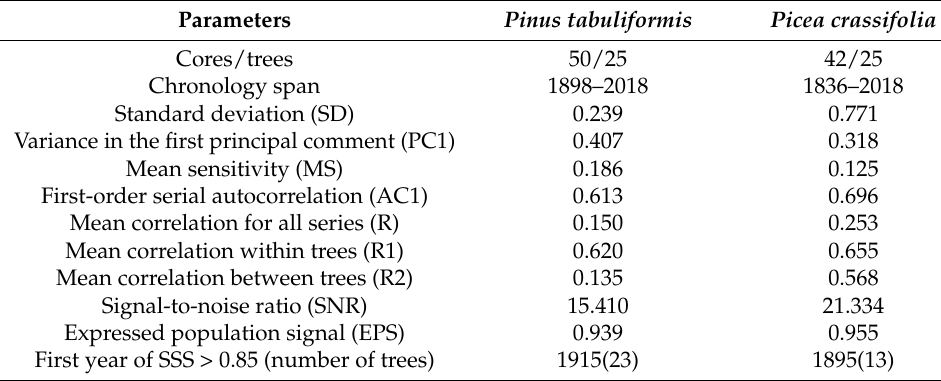
Table 2. Statistical parameters of the standard